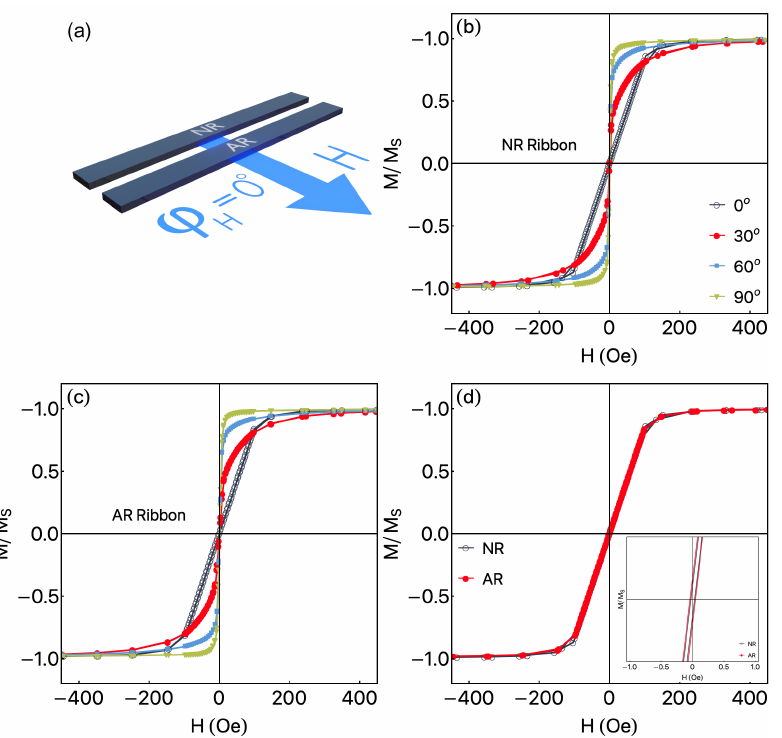
Figure 4. Magnetization curves for NR and AR ribbons. ( a ) Definition of ϕ H , in which ϕ H = 0 ◦ is assumed to be when the magnetic field is perpendicular to the main axis of the ribbon. ( b ) Normalized magnetization curves for the NR ribbon, measured at distinct ϕ H values. ( c ) Similar plots for AR ribbon. ( d ) NR and AR magnetization curves measured for ϕ H = 0 ◦ , showing the mirroring between the results. Inset depicts the low field curve, showing the coercive field of our